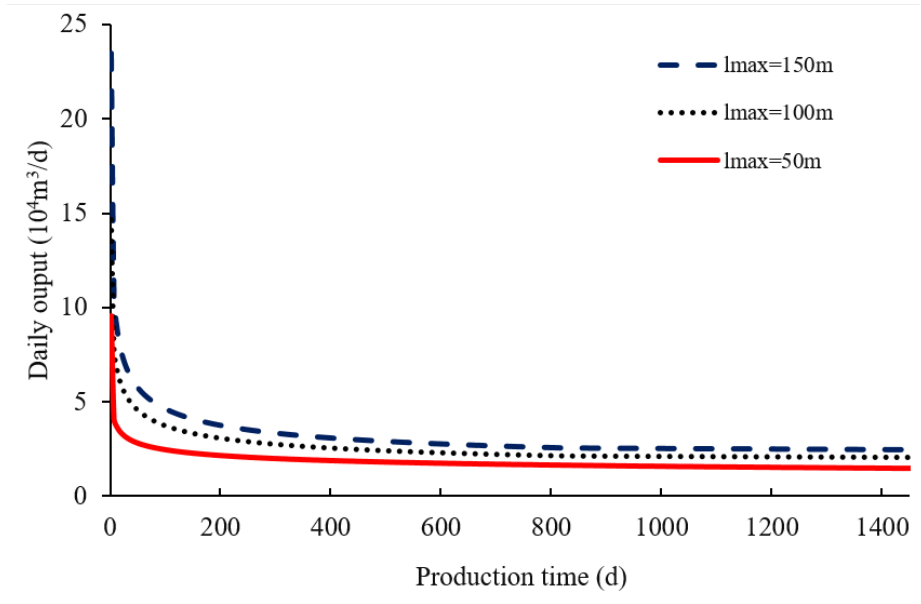
Figure 7. The influence of maximum fracture length on the daily gas production.